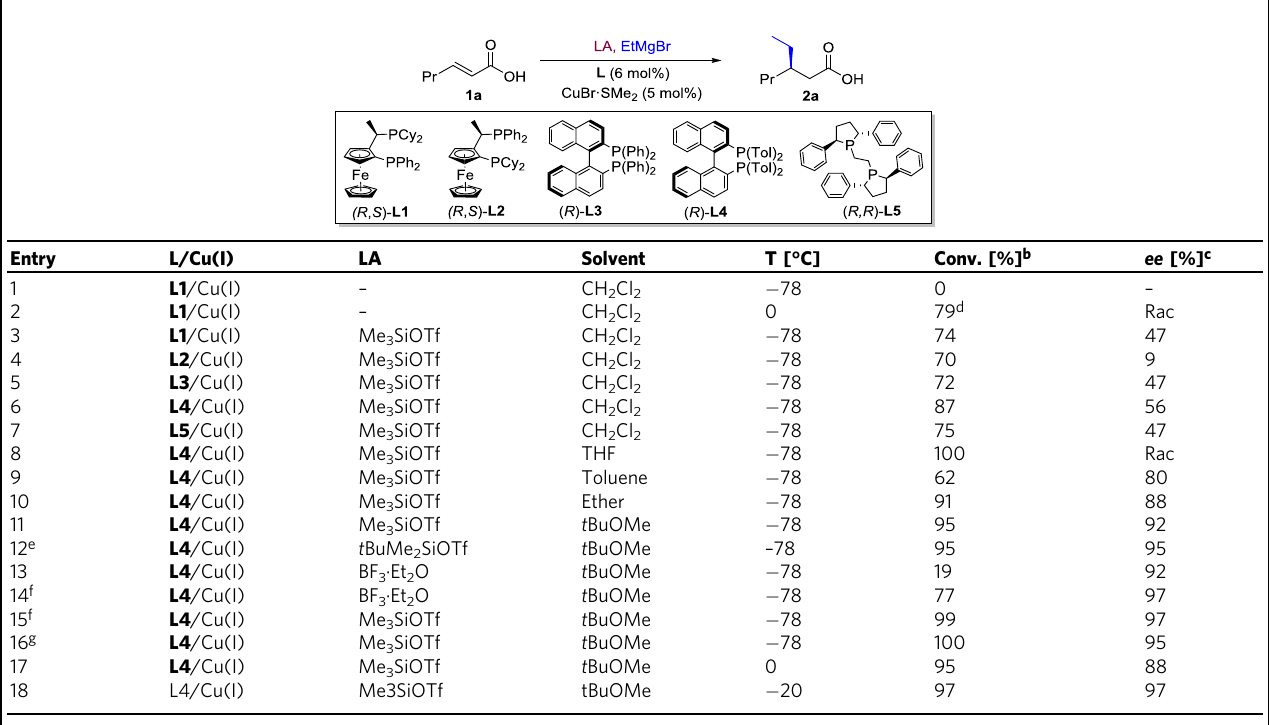
Table 1 Development of the catalytic system for direct asymmetric conjugate addition of EtMgBr to carboxylic acid 1a